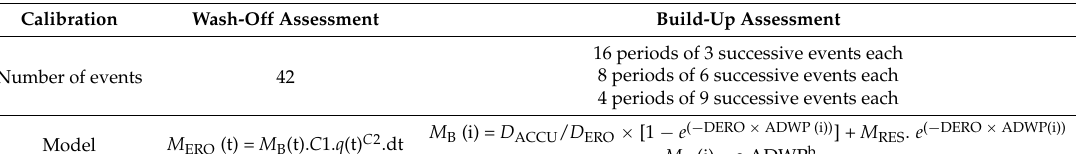
Table 3. Calibration methodology of wash-off and build-up